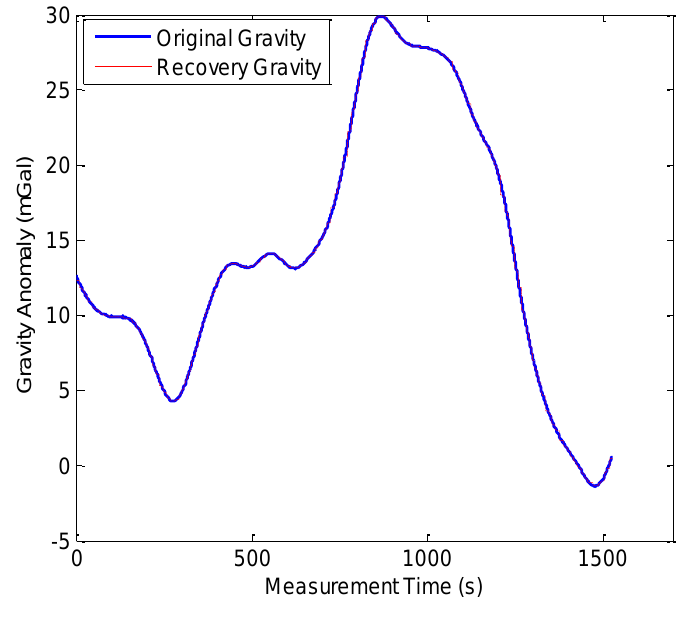
Figure 12. Reconstruction result of NIPM in F401.